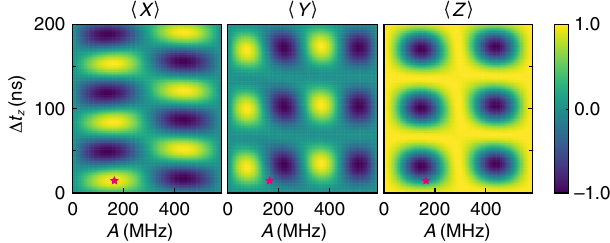
, σ , and σ as a x y z 4 . 76 ns. The and A with Δ t z p ¼